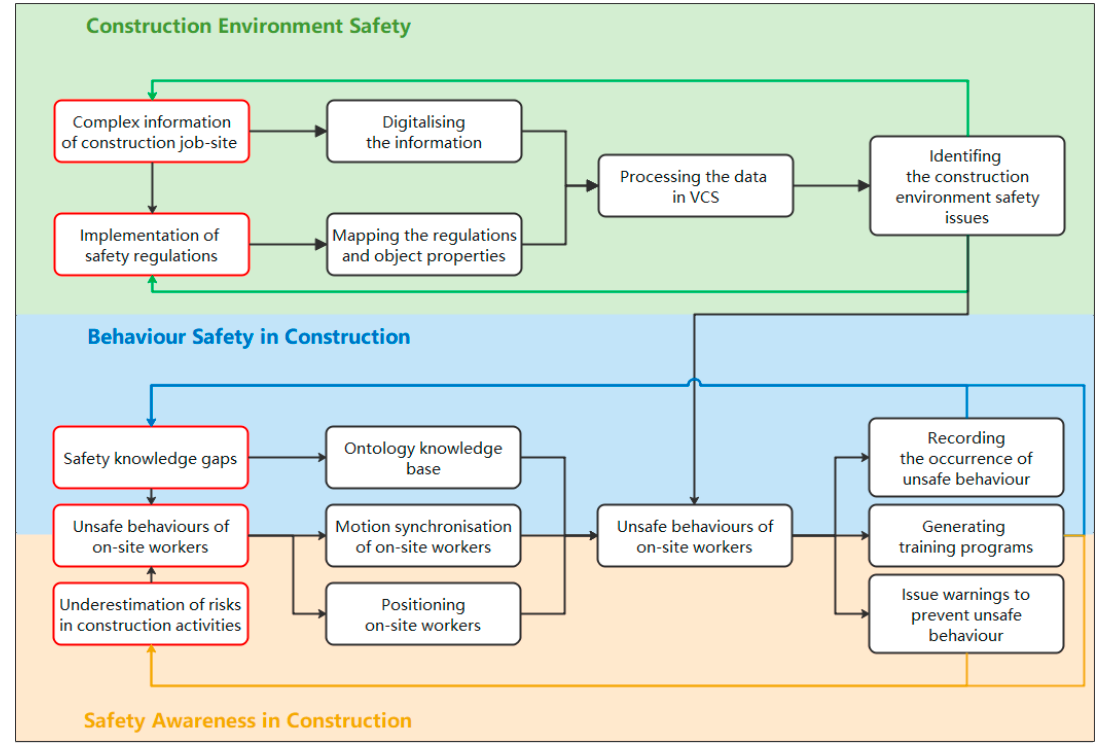
Figure 7. The approaches used in the existing research to improve construction workforce safety.